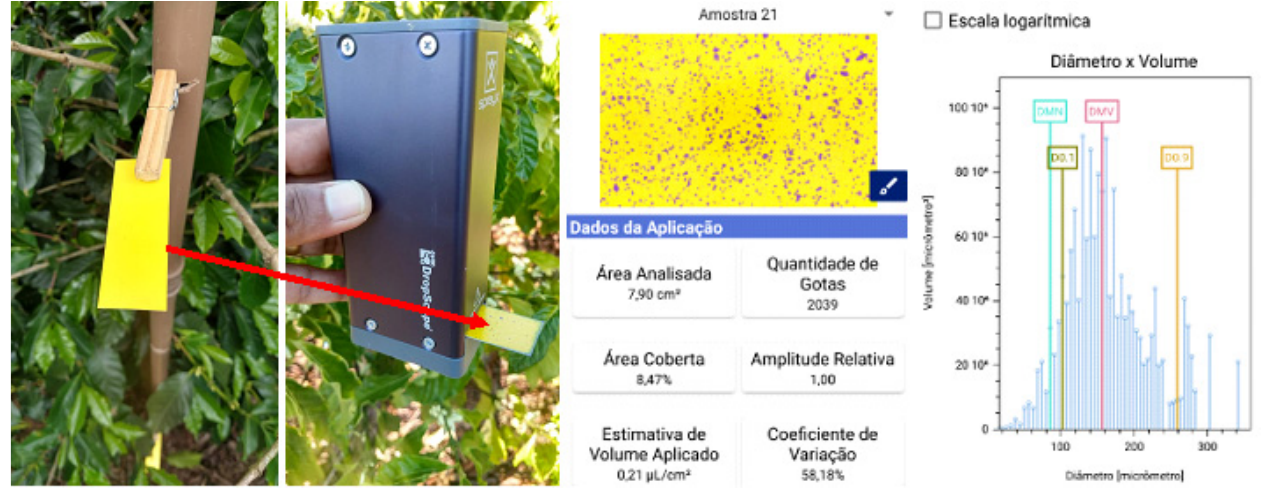
Figure 8. Attachment of water-sensitive labels to targets, DropScop ® Wirelles system for reading labels, and reporting of droplet deposition variables.